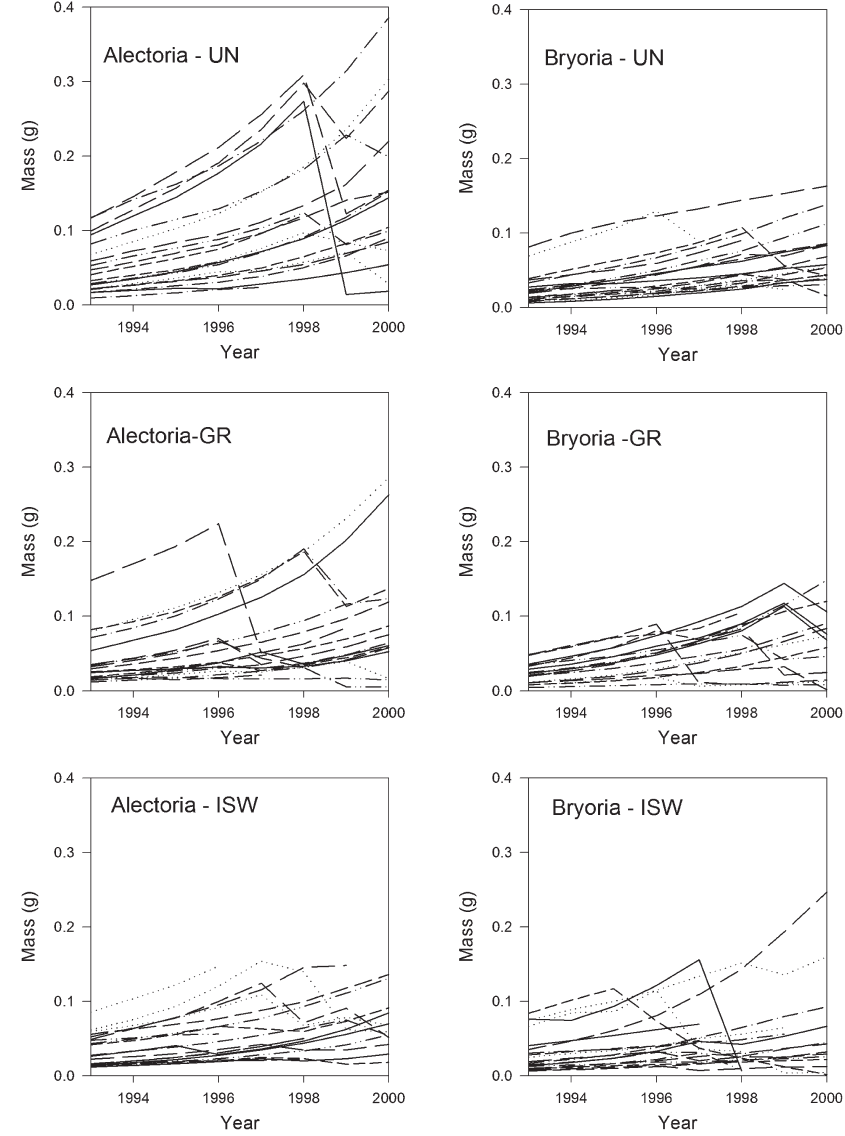
Fig. 4. Mass (g) of individual growth-rate replicates of Alectoria sarmentosa and Bryoria spp. in the unlogged control area (UN), group retention area (GR), and irregular shelterwood area (ISW) at Lucille Mountain, fall 1993-fall 2000 (S. Stevenson, unpubl. data; methods and site description in Jull & Stevenson,